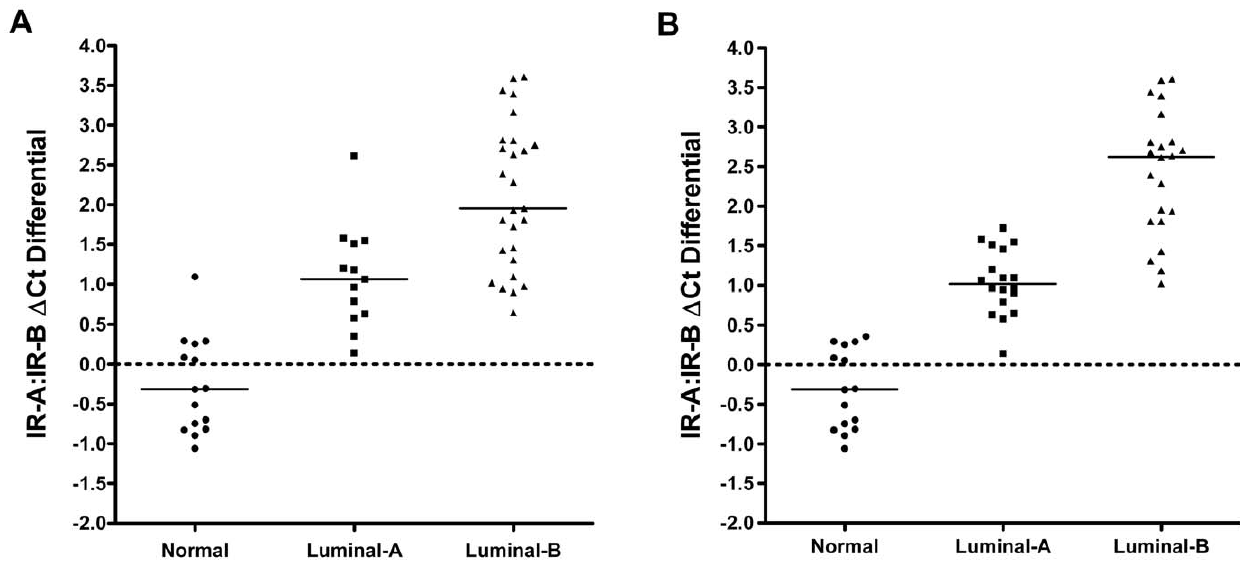
Figure 6. IR-A:IR-B D Ct differential in subtypes of ER + breast cancer. Scatter plot representation of calculated IR-A:IR-B D Ct differentials with regard to sample subtype (normal, luminal-A, or luminal-B) classification determined by a shrunken centroid classifier-based methodology (A) and a hierarchical clustering analysis (B). All subtype pair-wise comparisons display a significant difference (two-sample t-test, P , 0.001). Black bars represent the median IR-A:IR-B D Ct differential within a particular sample